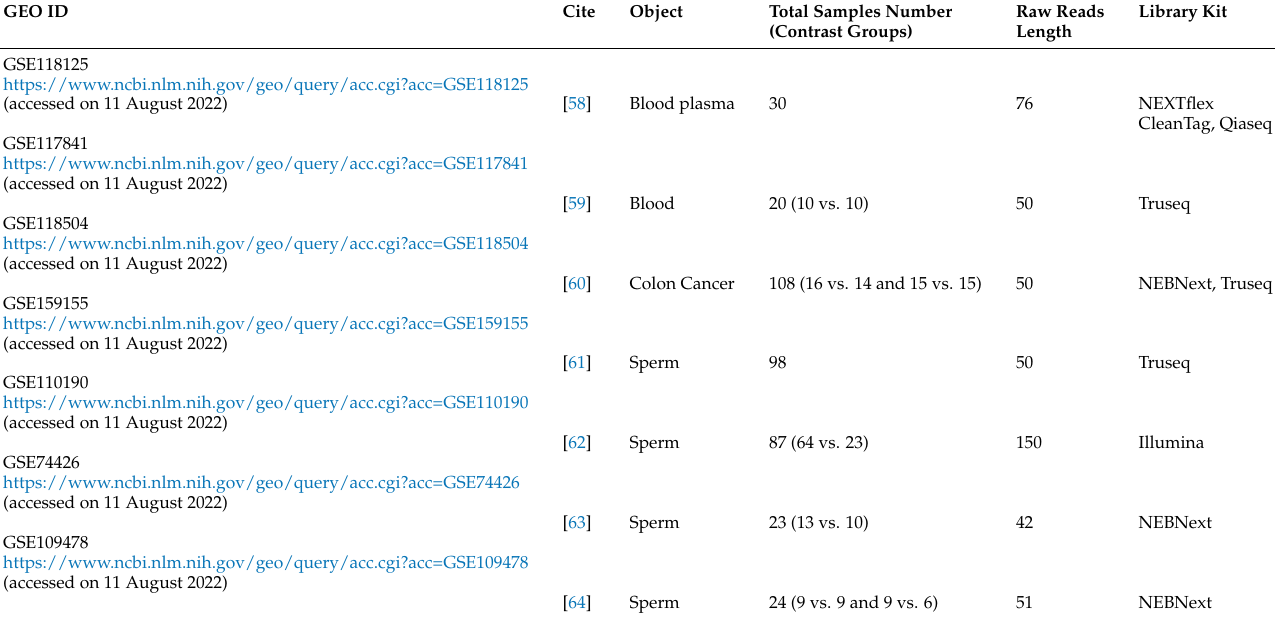
Table 4. Description of